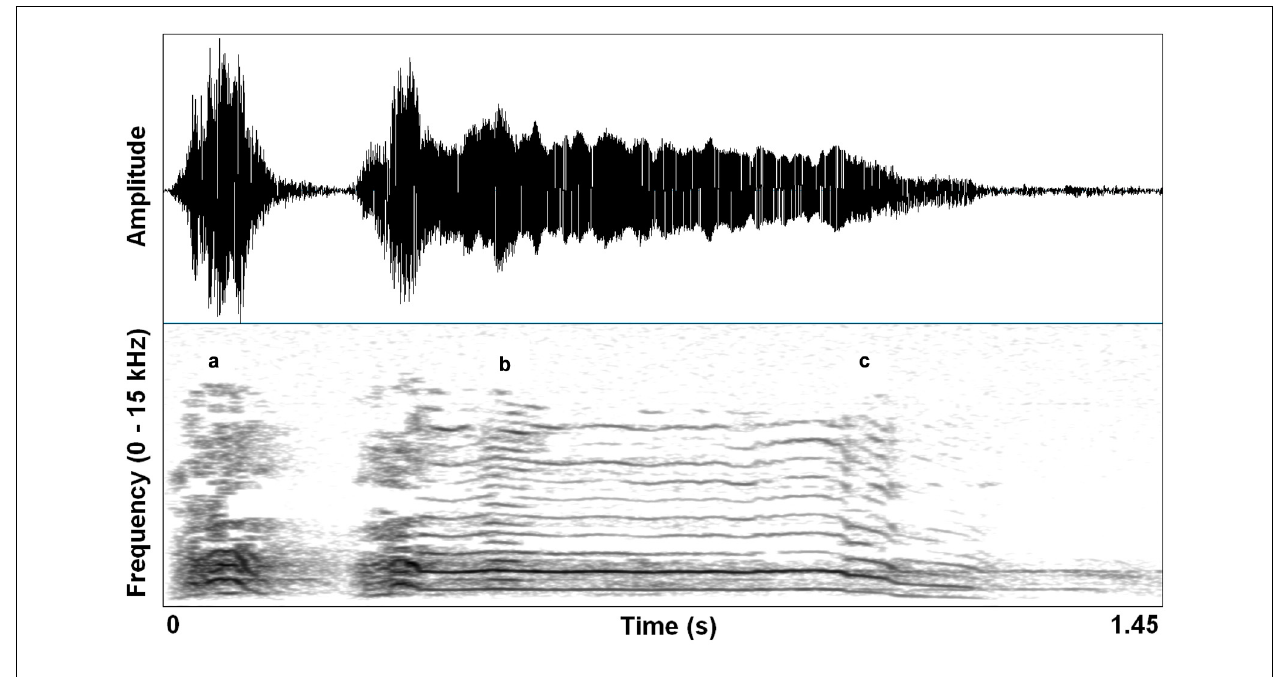
FIGURE 1 | Waveform and spectrogram (FFT method, window length – 0.005 s, Gaussian window shape, dynamic range – 50 dB) of a single coyote call ( Canis latrans ). Three nonlinear acoustic features are noted by (a) deterministic chaos, (b)